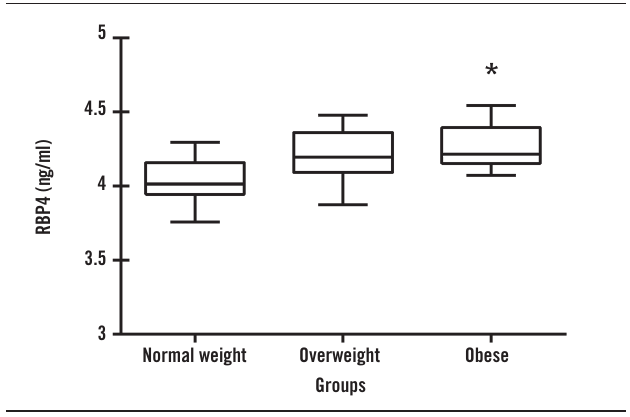
figurE − Serum RBP4 levels in the study